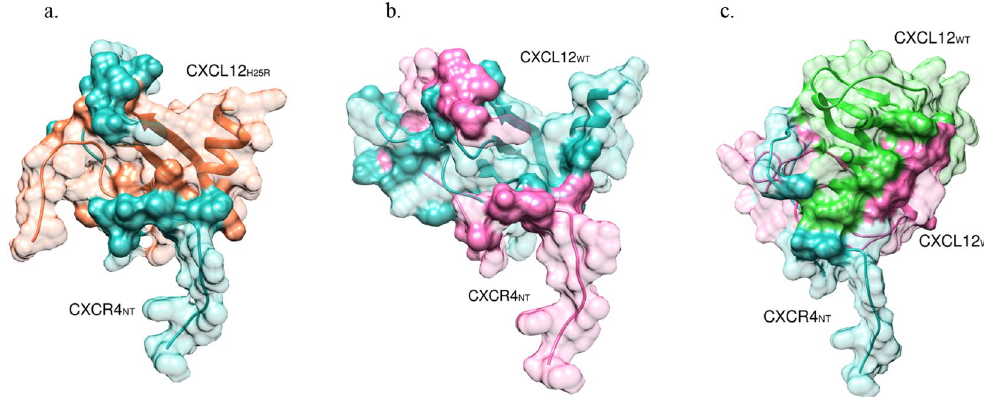
Figure 12. PRISM predictions for ( a ) CXCL12 H25R (orange)-CXCR4 NT (blue) interaction, ( b ) CXCL12 WT (pink)-CXCR4 NT (blue) interaction, and ( c ) CXCL12 WT :CXCR4 NT (pink:blue)-CXCL12 WT (green) trimer structure. Binding residues are indicated as